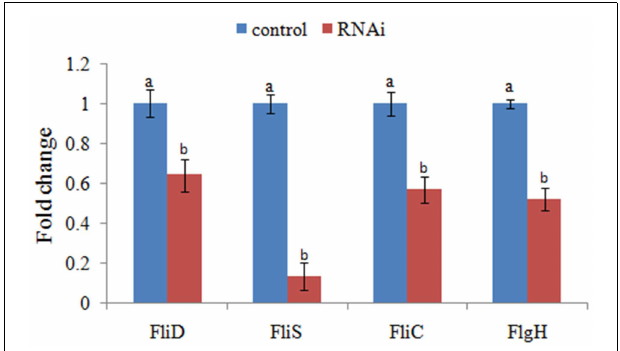
FIGURE 6 | The adhesion capacity of stable silenced V. alginolyticus to mucus. The data are presented as the means ± S.D. ( n = 3 ). The means of the treatments not sharing a common letter are significantly different at P < 0 . 05 , as assessed using One-Way ANOVA followed by Dunnett’s test.